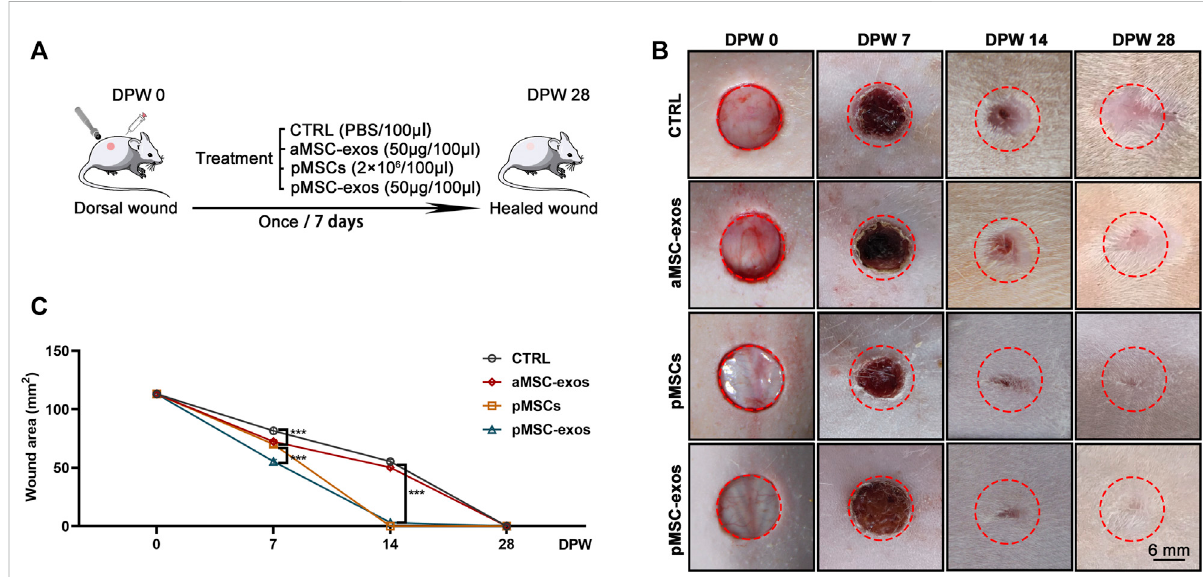
FIGURE 2 pMSC-exos accelerate wound healing rate. (A) Schematic drawing of animal experimental design. (B) Morphological changes of the wounds during the healing period. (C) Quantitative evaluation of changes in wound area during the healing period. Mean ± SEM; *** p < .001, n = 8. CTRL, control; aMSC-exos, adipose MSC-derived exosomes; DPW, days post